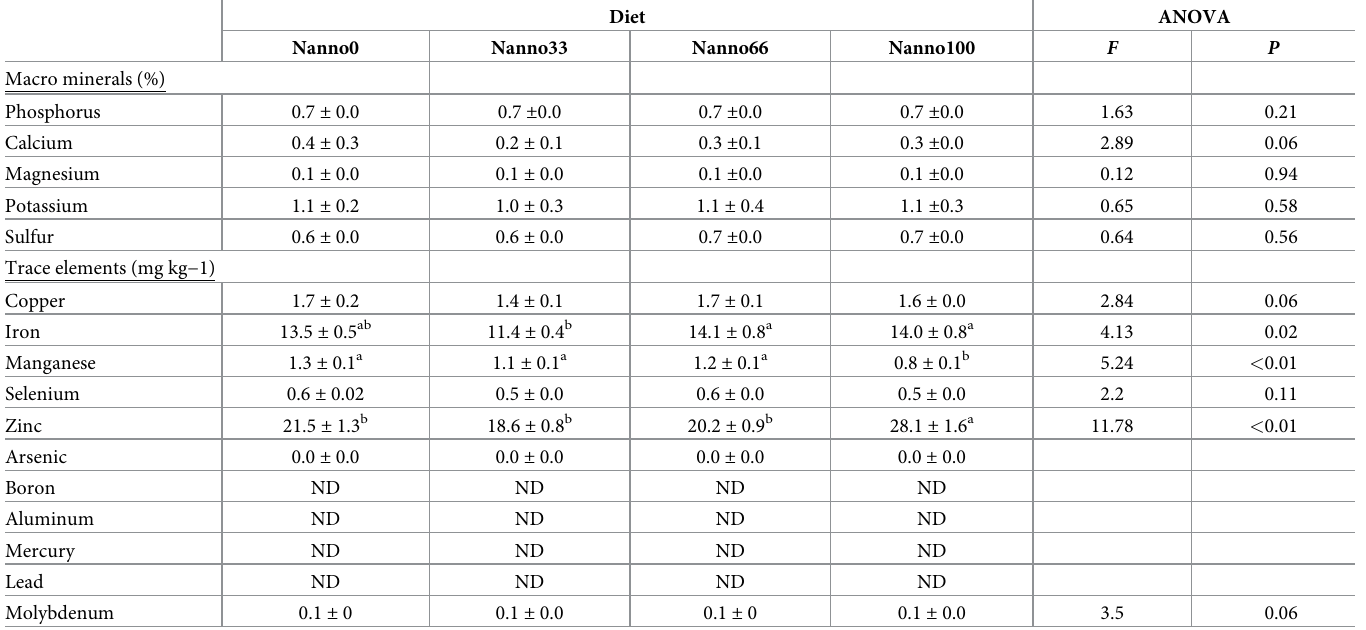
Table 12. Macro minerals and trace elements content (wet weight basis) of fillets from Nile tilapia after 84 days on the experimental diets.